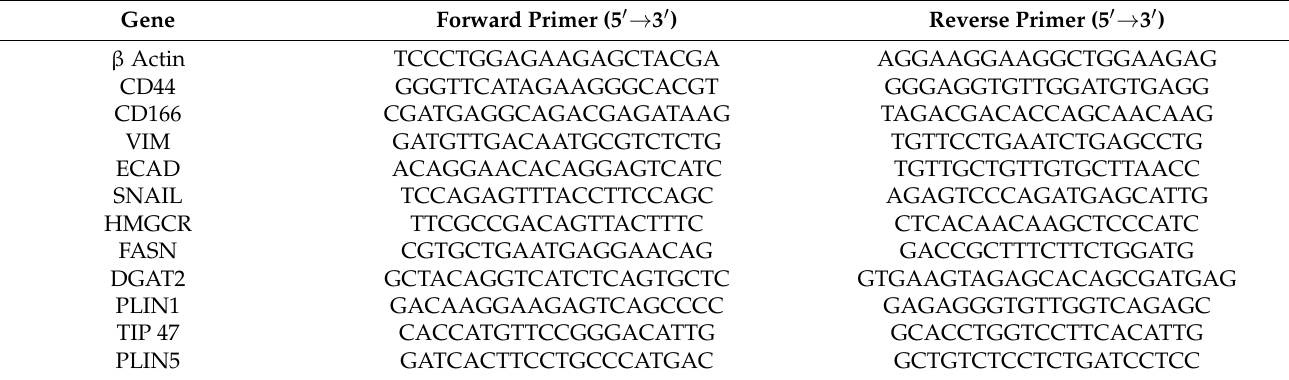
Table 1. List of Primers Used for RT qPCR